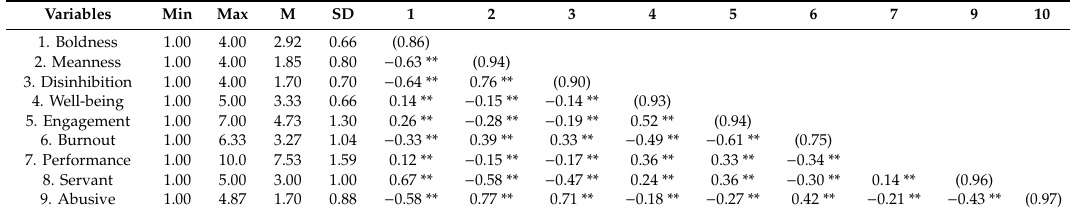
Table 2. Descriptive statistics for Sample 2 (employees) at Time 1 ( N = 668).